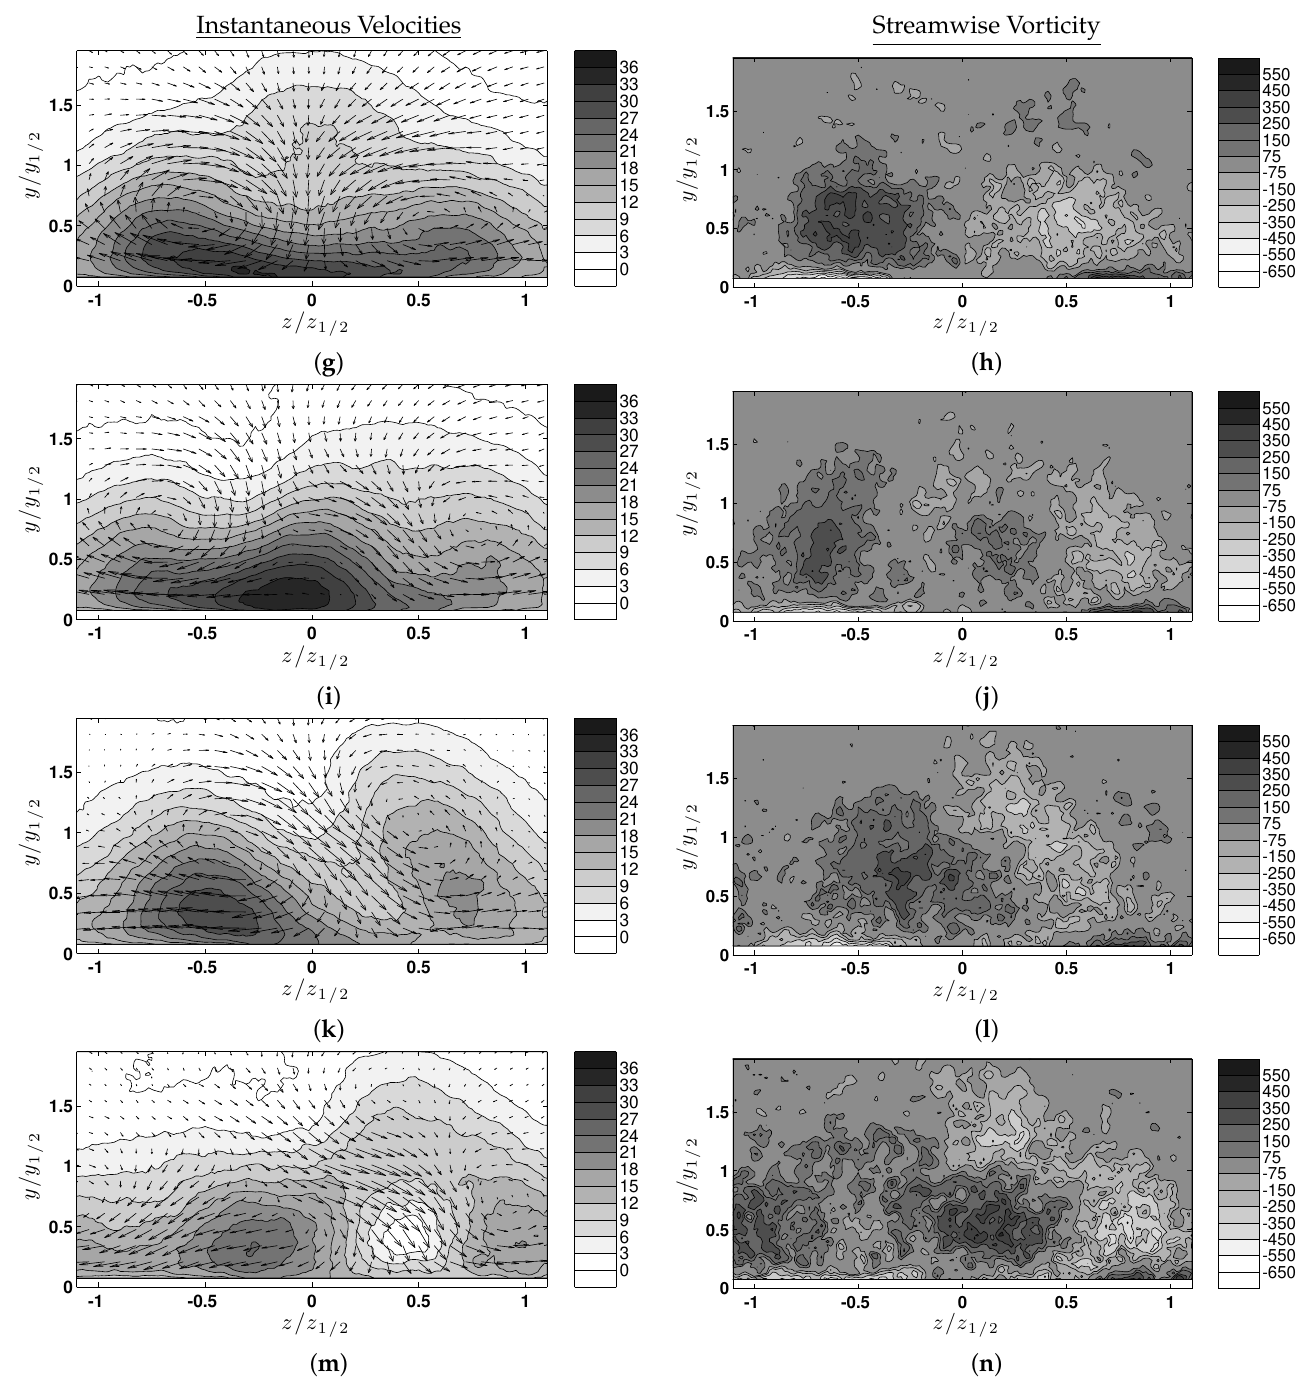
Figure 9. POD reconstruction of the instantaneous velocity ( m / s ) using the first 10 modes and the reconstructed instanta- neous streamwise vorticity ( 1/ s ) at x / D = 30. The mean streamwise velocity (normalized) and mean streamwise vorticity are shown in the first